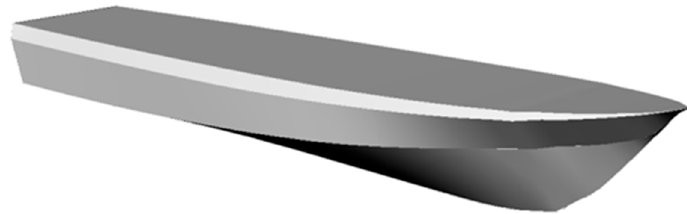
Figure 2. Complete schematic diagram of the series 62 craft. Table 1. Specifications of the series 62 craft.